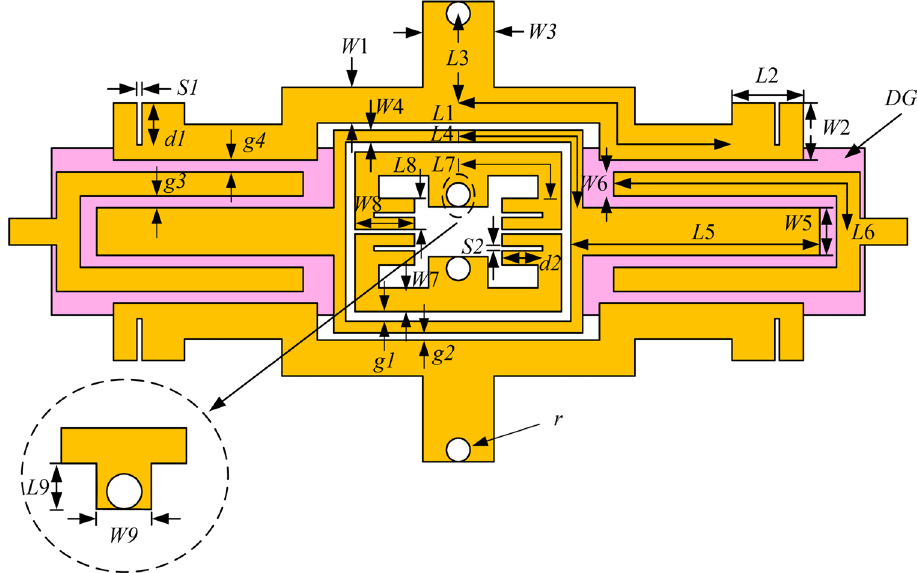
Figure 11. The layout of the proposed wideband BPF.